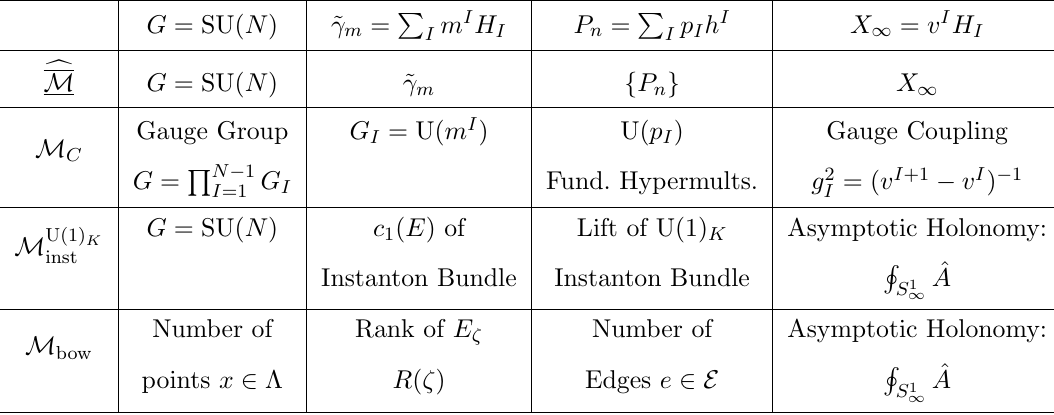
Table 1 . This table shows the di(cid:11)erent realizations of the data of the 4D gauge group, relative asymptotic magnetic charge, ’t Hooft charges, and Higgs